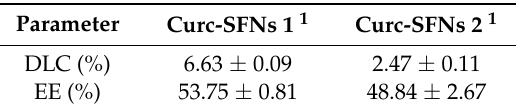
Table 2. Drug loading and encapsulation efficiency of the curcumin-loaded silk fibroin nanoparticles synthesized by physical adsorption (Curc-SFNs 1) and curcumin-loaded silk fibroin nanoparticles synthesized by coprecipitation (Curc-SFNs